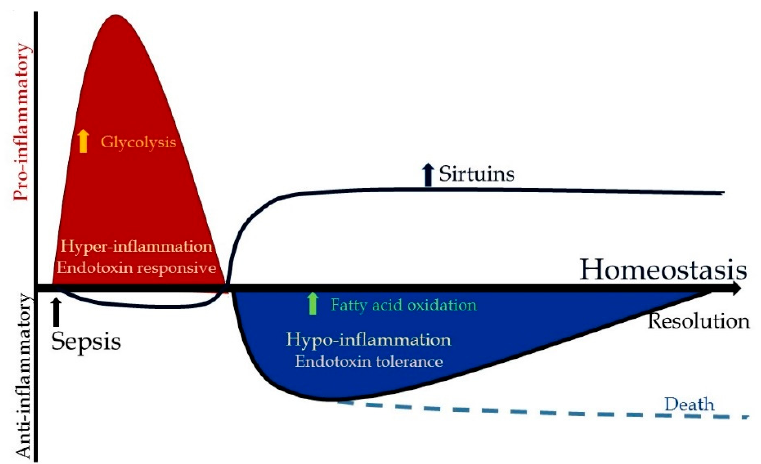
Figure 1. Immune response to sepsis: sepsis inflammation in immune cells transitions from the hyper-inflammatory to the hypo-inflammatory phase. There is increased glycolysis in the endotoxin-responsive hyper-inflammatory phase, while the endotoxin-tolerant hypo-inflammatory phase is associated with increased fatty acid oxidation in immune cells.